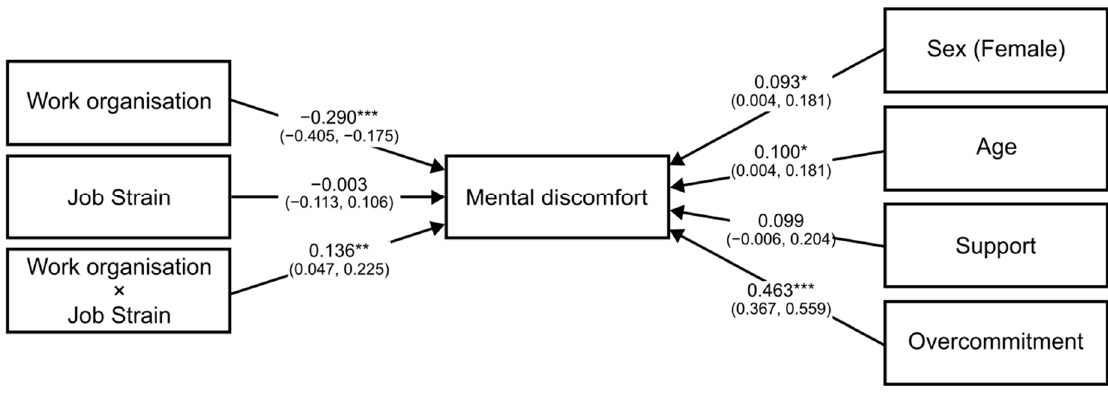
Figure 1. Diagram of the job strain model. Note: ***: p < 0.001; **: p < 0.01; * p < 0.05.